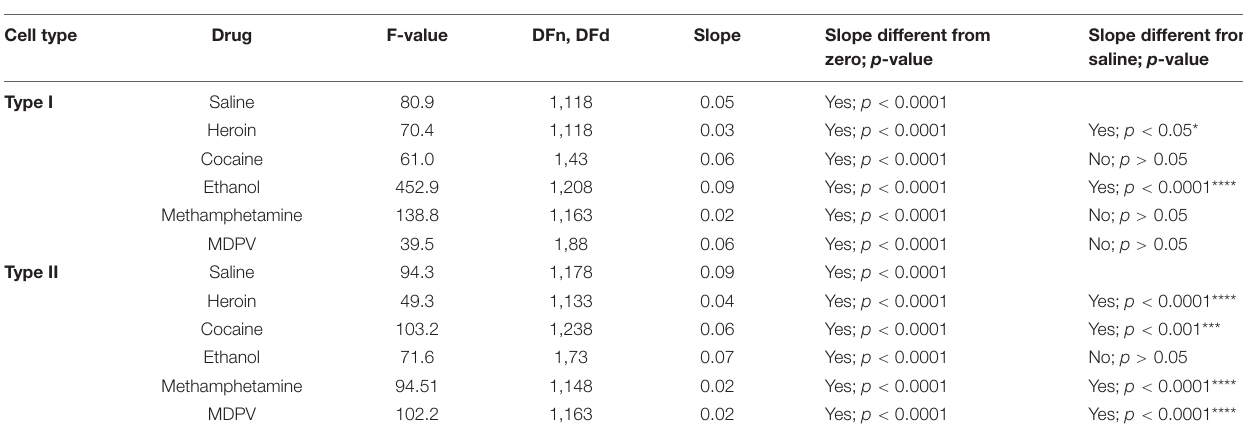
FIGURE 7 | Drug exposure differentially alters action potential amplitude. (A) Cocaine exposure significantly reduces action potential amplitude of layer V pyramidal cells compared to saline. (B) Cocaine significantly reduces the action potential amplitude of type I cells relative to saline, whereas ethanol significantly increases action potential amplitude. (C) Heroin significantly reduces action potential amplitude of type II, but not type I cells, relative to saline. Numbers within histogram bars represent the number of recorded cells. * Indicates p < 0.05 vs. saline; ** indicates p < 0.01 vs. saline. TABLE 1 | Linear regression analyses